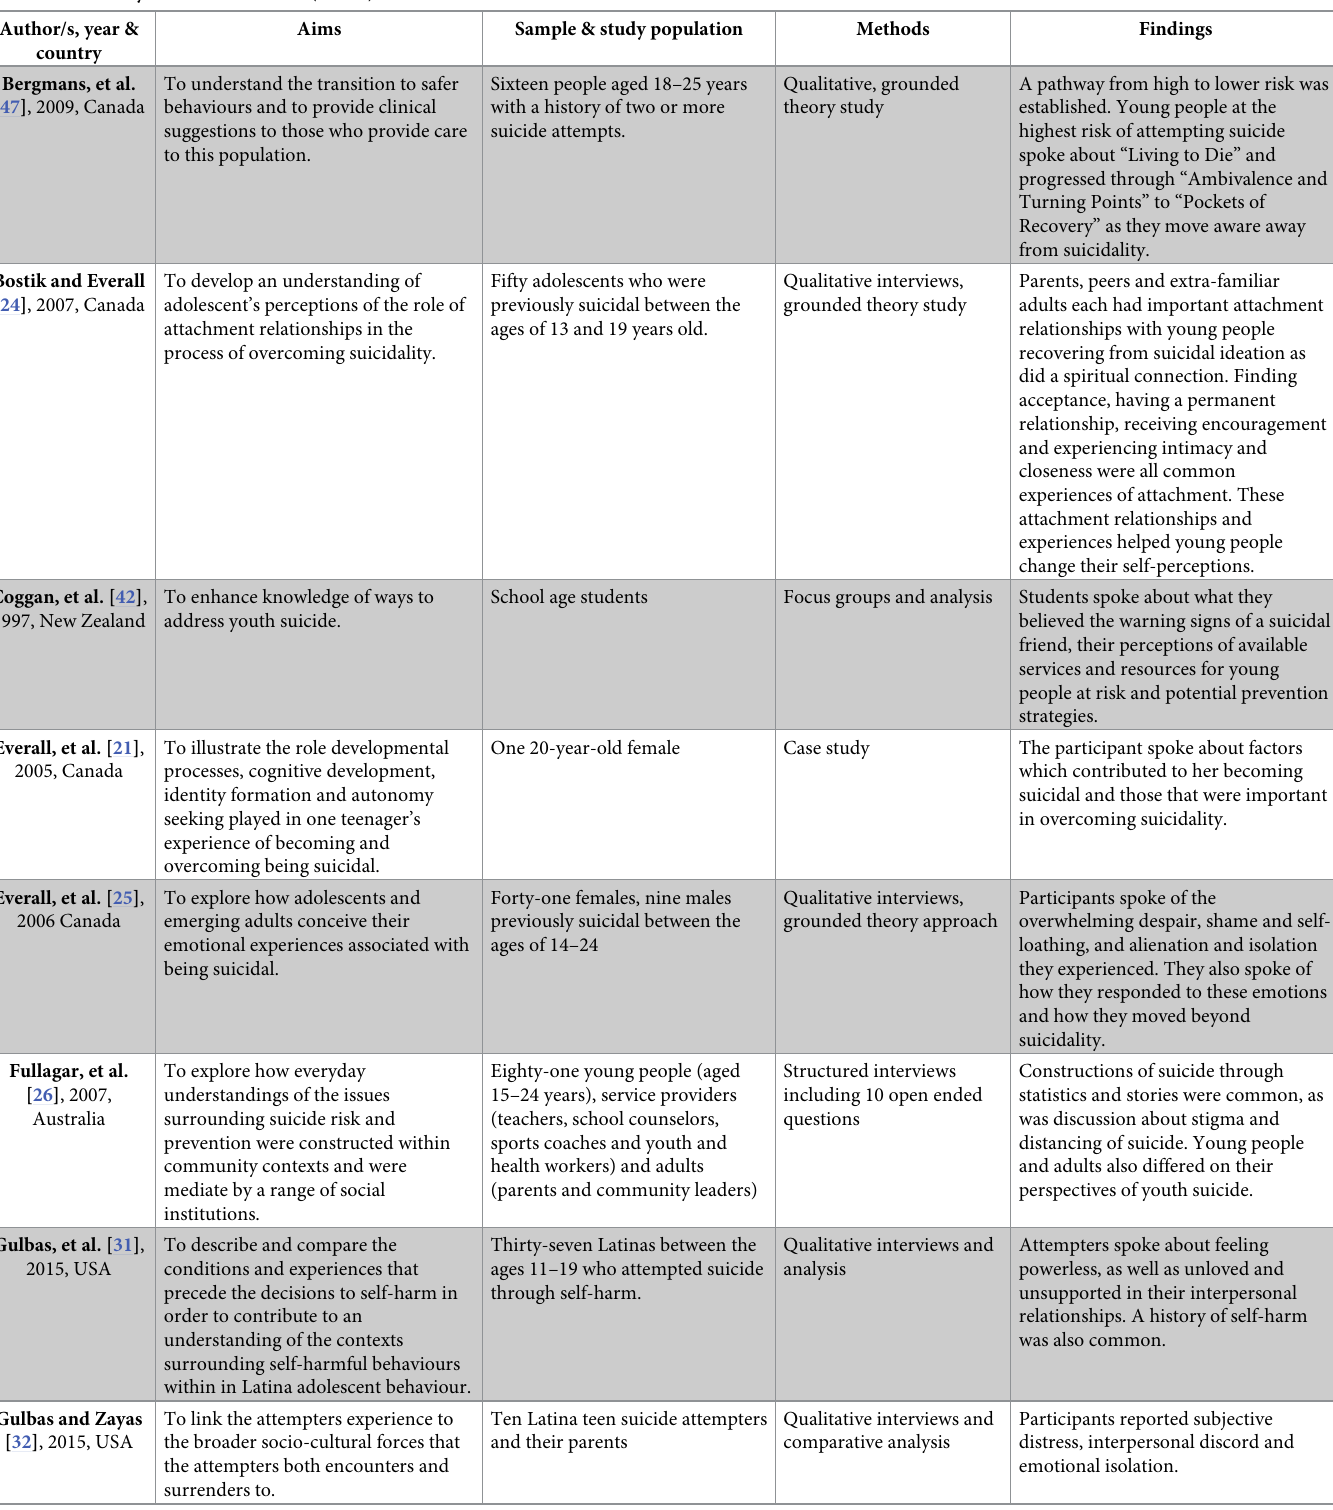
Table 5. Summary of included studies (n =